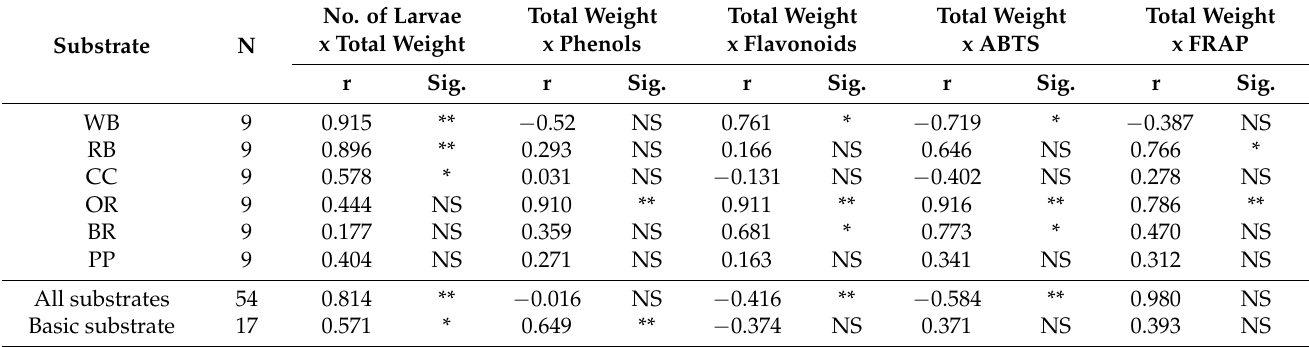
Figure 4. The antioxidant potential as determined by FRAP assay of ( a ) agri-food substrates and ( b ) Tenebrio molitor larvae reared on the respective substrates (WB, Wheat bran; RB, Rice bran; CC, Corn cob; OR, Olive oil residues; BR, Biogas residues; PP, Potato peel). Different bar colors depict supplementation percentage of post-distillation residues of medicinal and aromatic plants (MAPs) in the substrates. Bars represent mean values of three replicates ± SE. Different letters depict significant differences regarding MAPs post-distillation residues supplementation in each substrate, while different symbols are used (*, †, ¥) to denote significant differences between substrates compared to the WB in the respective supplementation percentage of MAPs post-distillation residues (0%, 10%, 20%, respectively). Table 6. Correlation analysis between the developmental characteristics of Tenebrio molitor larvae and their content in total phenols, total flavonoids and antioxidant potential measured with two assays (ABTS and